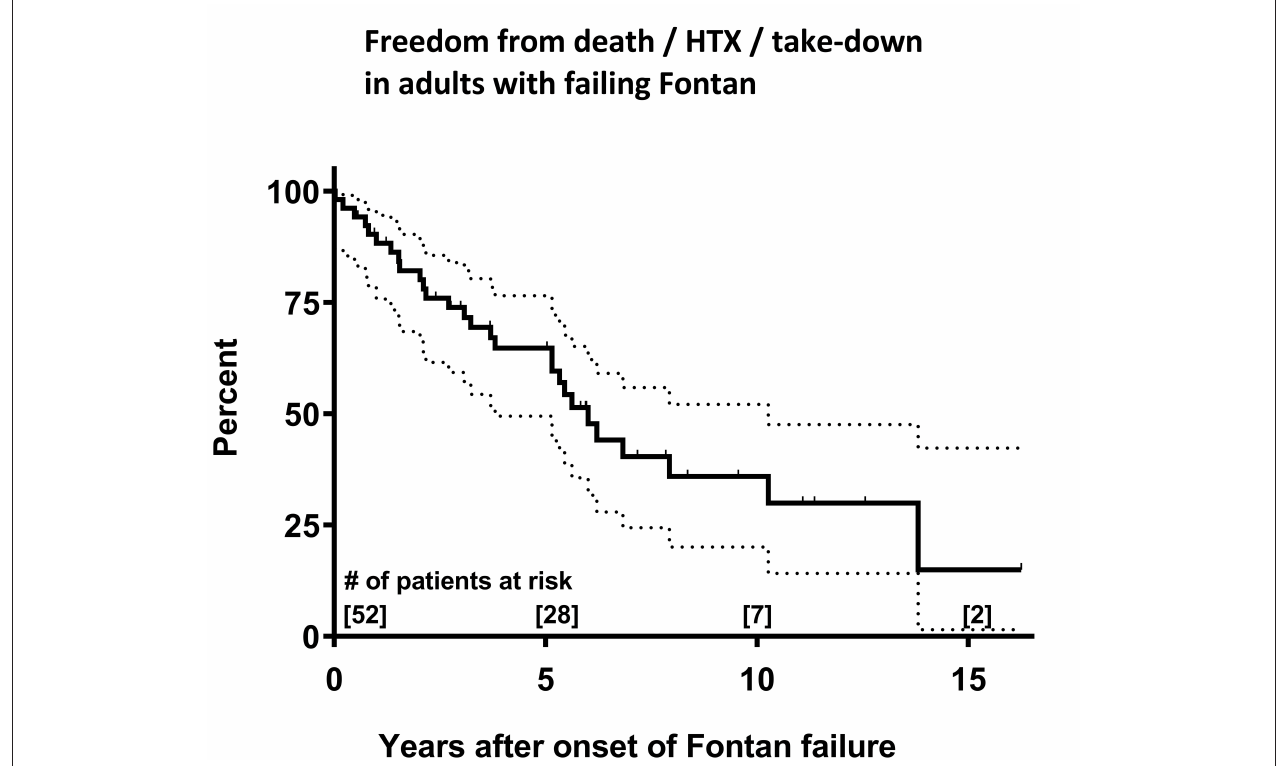
FIGURE 1 | Kaplan-Meier survival estimates for the combined endpoint of survival and freedom from cardiac transplantation and Fontan take-down in failing Fontan patients after onset of failure. Dotted lines represent 95% confidence interval. HTX, cardiac transplantation.